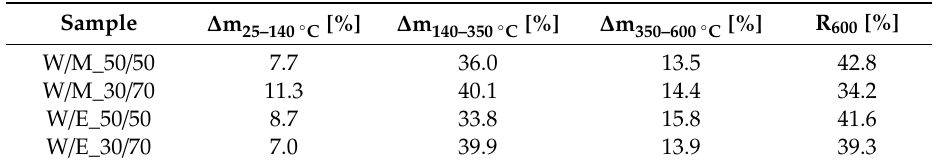
Figure 1. The TG and DTG curves of the natural extracts from Equisetum arvense . Table 2. Percentage mass losses of horsetail extracts ( ∆ m) in various temperature regimes and the residue after thermal decomposition (R 600 ).